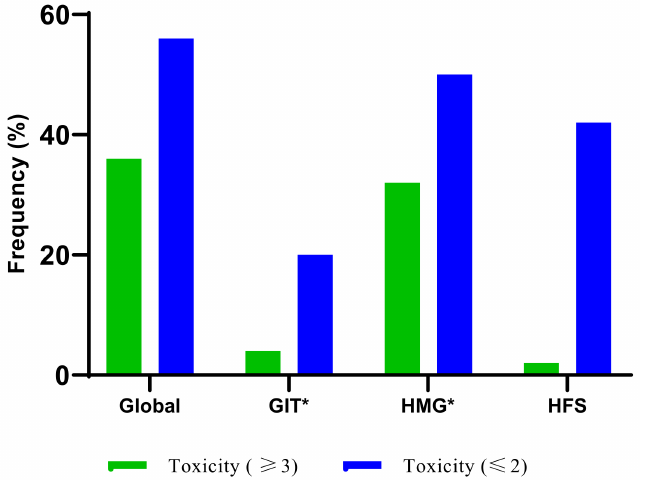
Figure 4. Plot of fluoropyrimidine adverse events markers during the total study period. (GIT, gas- trointestinal; HMG, haematological; HFS, hand-foot-syndrome). Global includes all fluoropyrimidine- related AEs. GIT* Gastrointestinal markers include nausea, vomiting, and diarrhoea. HMG* Haema- tological markers include neutropenia, leukopenia, thrombocytopenia, and anaemia. In grades ≥ 3, this also includes dose reduction and treatment discontinuation. In grade ≤ 2, this does not include dose reduction and treatment